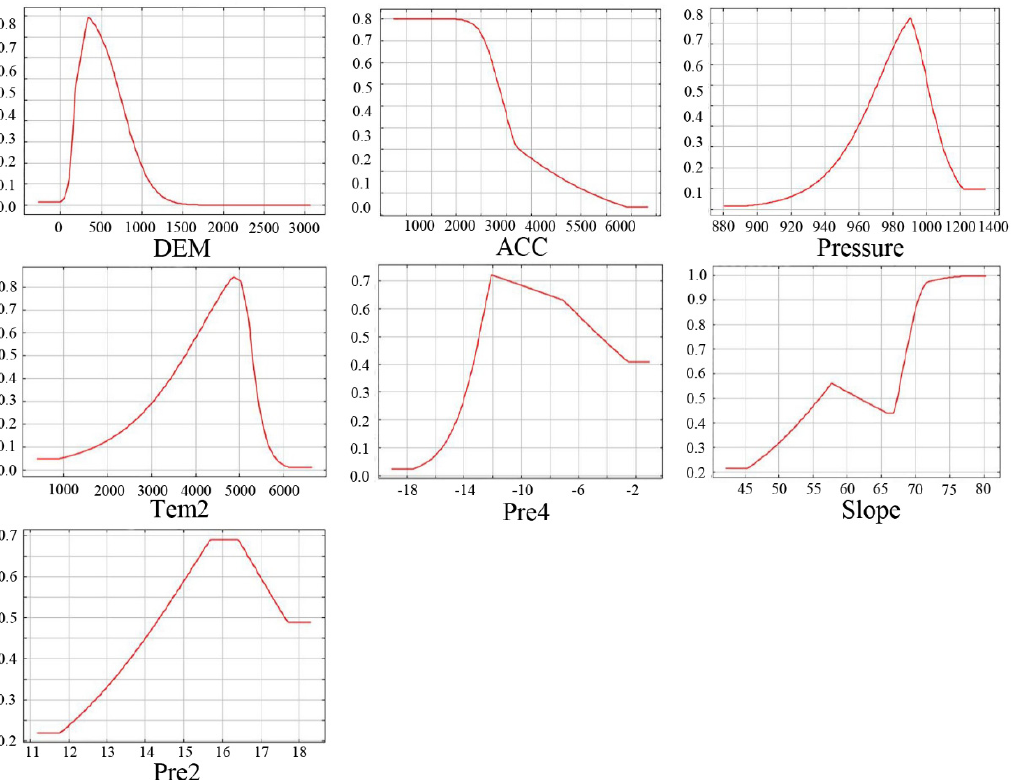
Figure A4. Feedback curves of dominant geographic environment variables for Chinese thuja. DEM represents digital elevation model; Acc represents accumulated temperature; Pressure represents air pressure; Tem2 represents annual average diurnal temperature difference; Pre4 represents precipitation deviation; Pre2 represents rainfall in the wettest season.